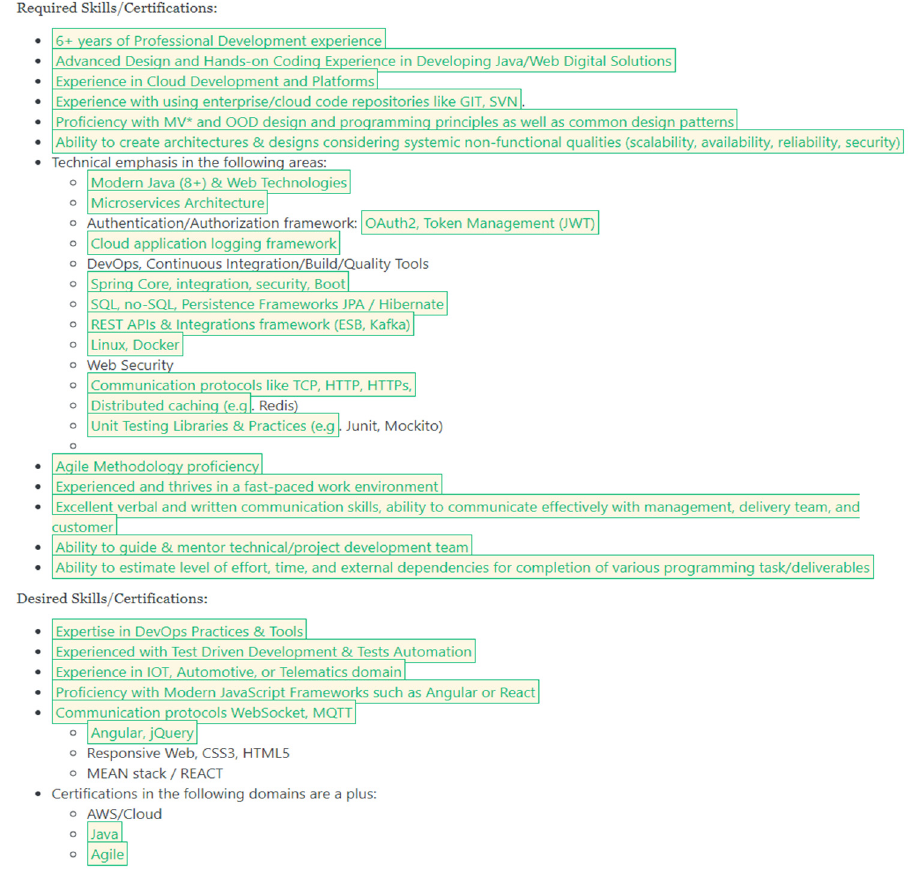
Figure 12. Part of a job advertisement processed by the basic machine learning method.